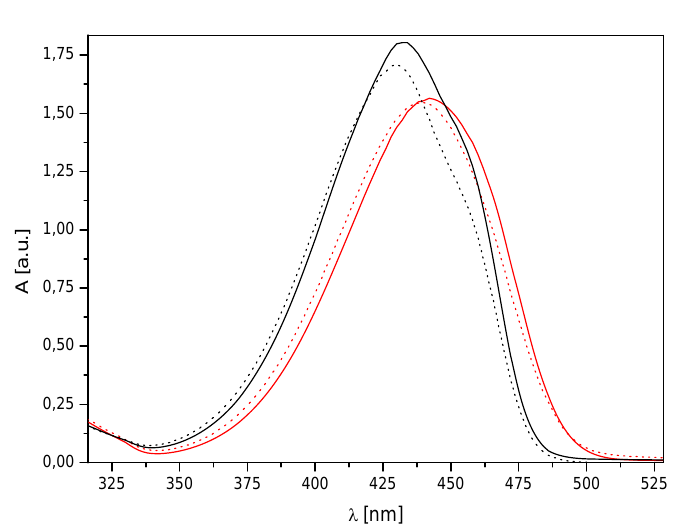
Figure 5. Absorption spectra of 4c in methanol ( E -isomer ⎯⎯ , Z -isomer ⋅⋅⋅⋅⋅⋅ .) and in toluene ( E -isomer ⎯⎯ , Z -isomer ⋅⋅⋅⋅⋅⋅ .).